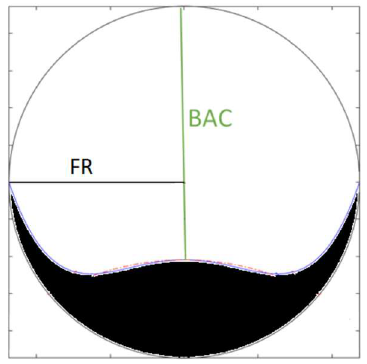
Figure 2. An axial cross-section of the HSCE model bubble. The white region represents air, and the black region represents the wake (a mix of air and sand) (Adapted from Torres Brauer et al. [19]).